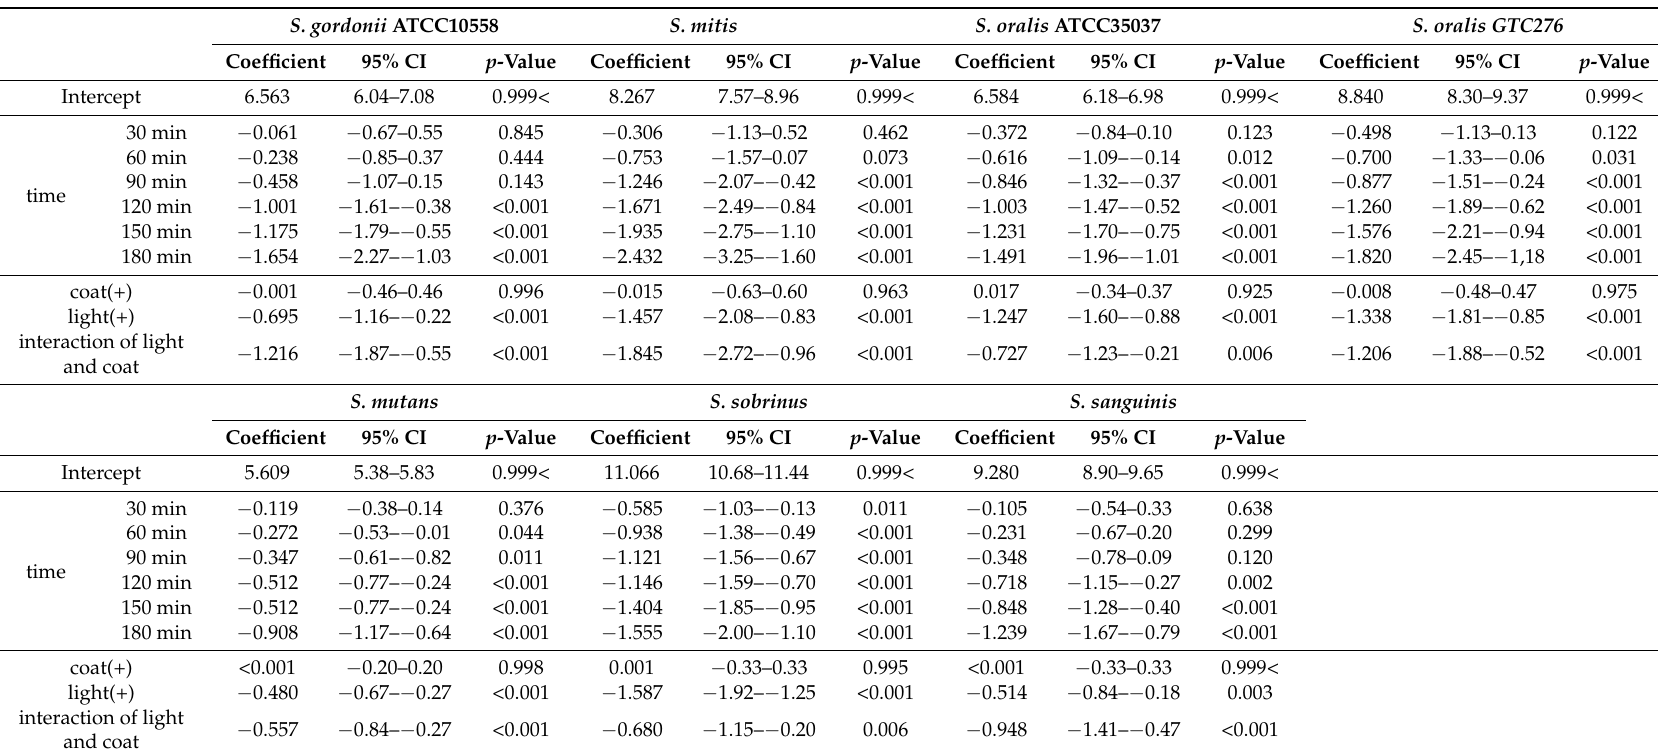
Table 1. Models of three way ANOVA for changes in bacterial counts. p -values less than 0.05 were considered statistically